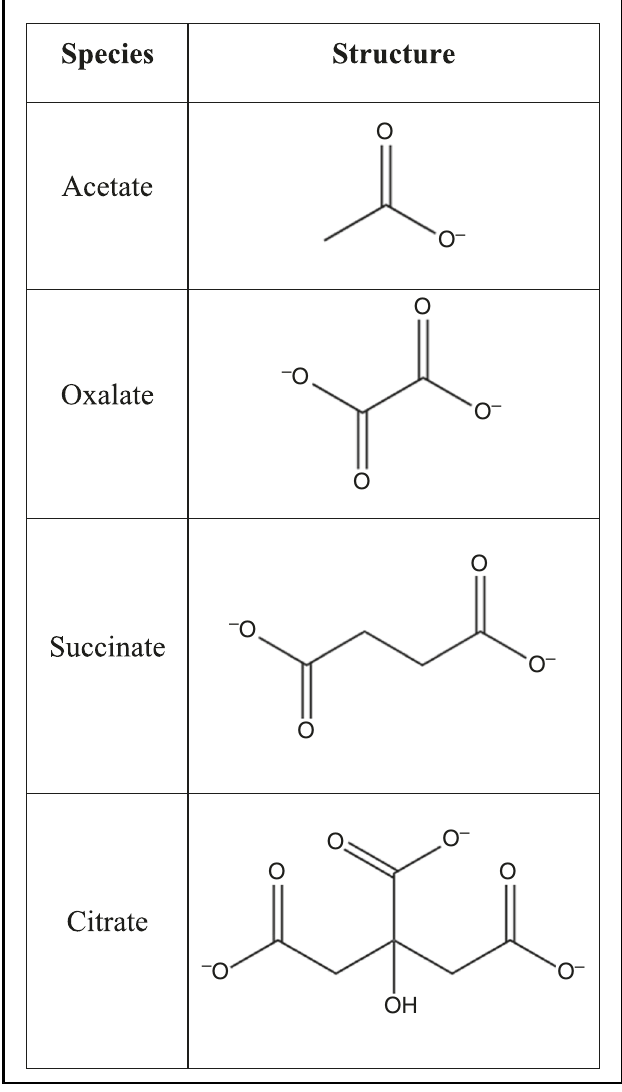
Table 2 Structures of the organic acids used in this